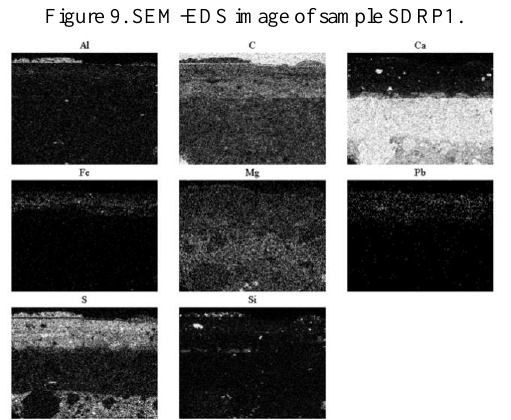
Figure 8. Cross section of SDRP1 showing several layers: (a) gypsum and aerial lime with traces of magnesium; (b) finish lime; (c), (d), (e), (f) sulphur, lead, iron; (g) sulphur, aluminium, iron and other; (h) gold leaf fragments.